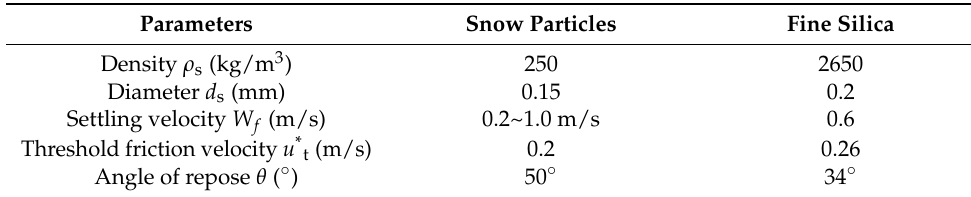
Table 1. Physical properties of snow particles and fine